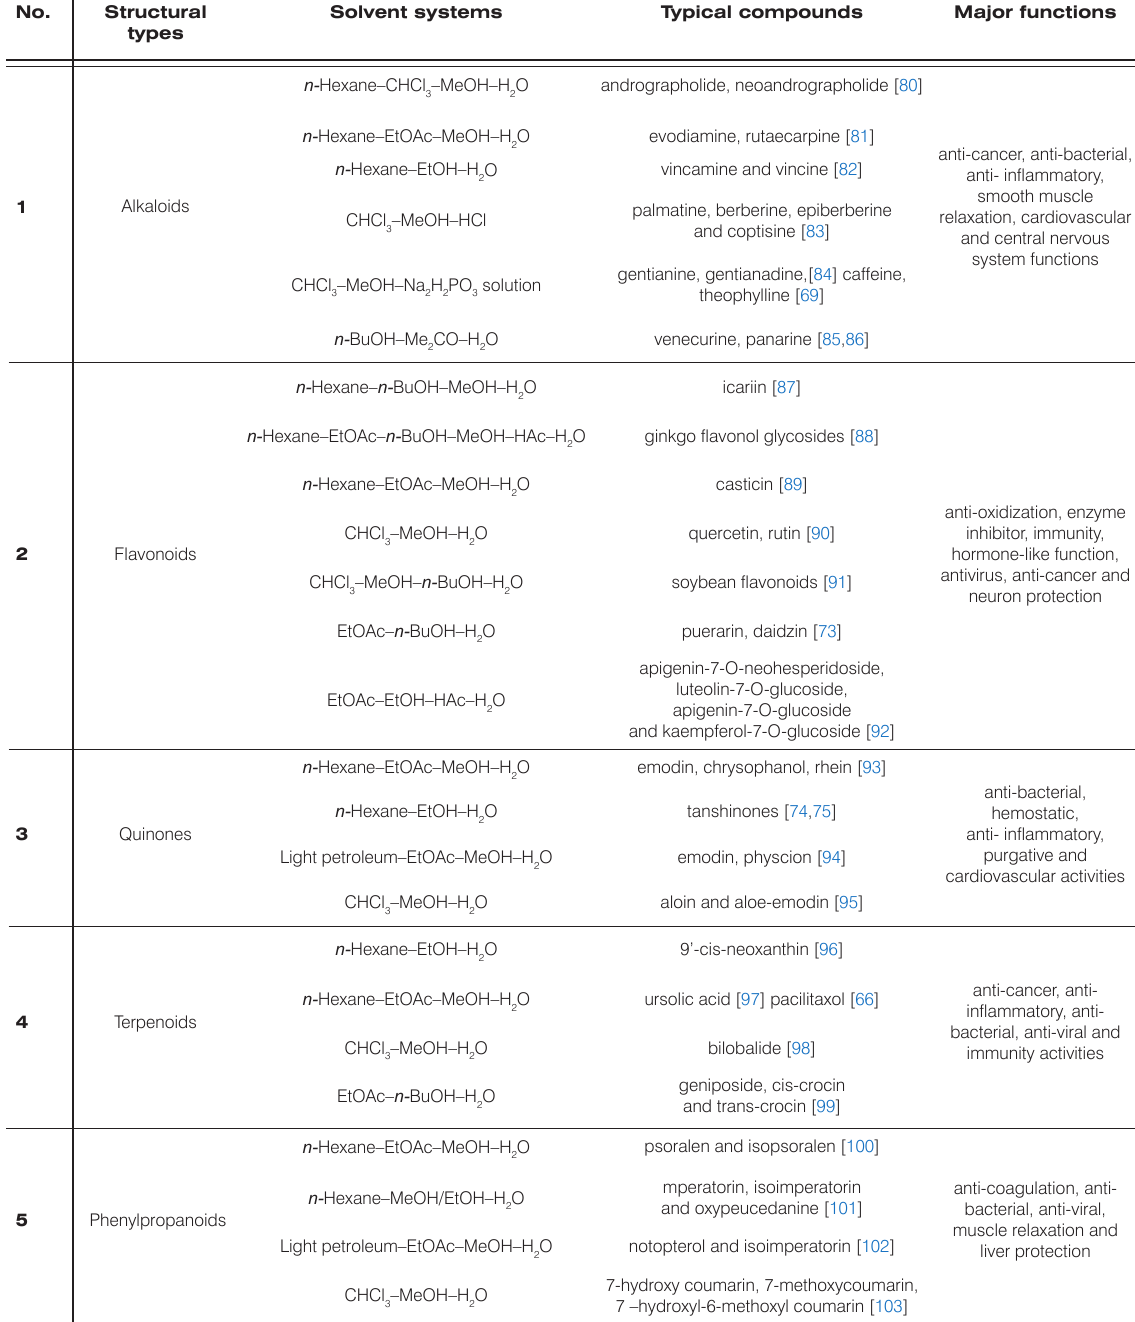
Table 1. Summary of most popular solvent systems used in separation of typical bioactive compounds.